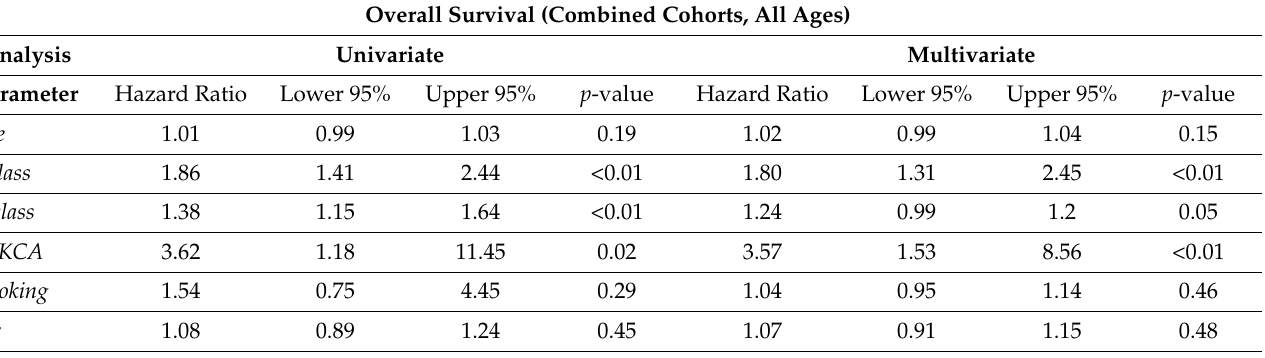
Table 2. Overview of unadjusted and adjusted hazard ratios for key clinico-pathological parameters. Overall Survival (Combined Cohorts, All